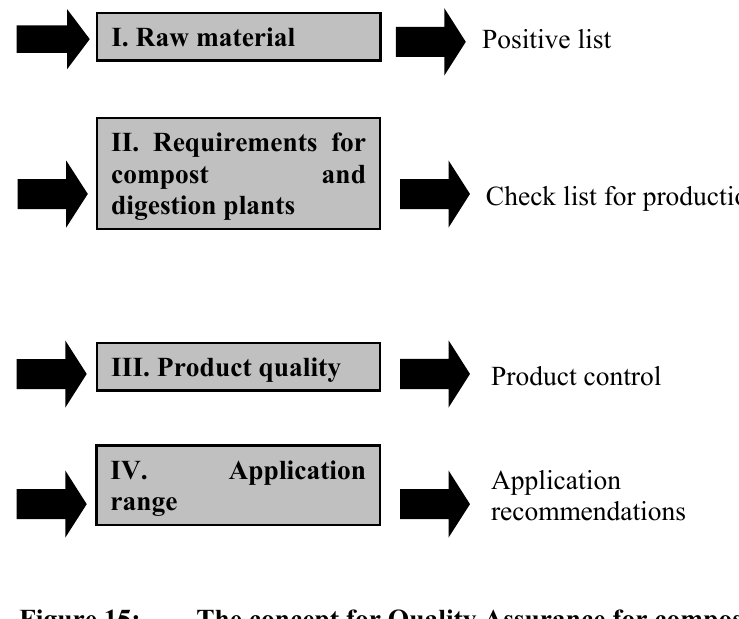
Figure 15: The concept for Quality Assurance for